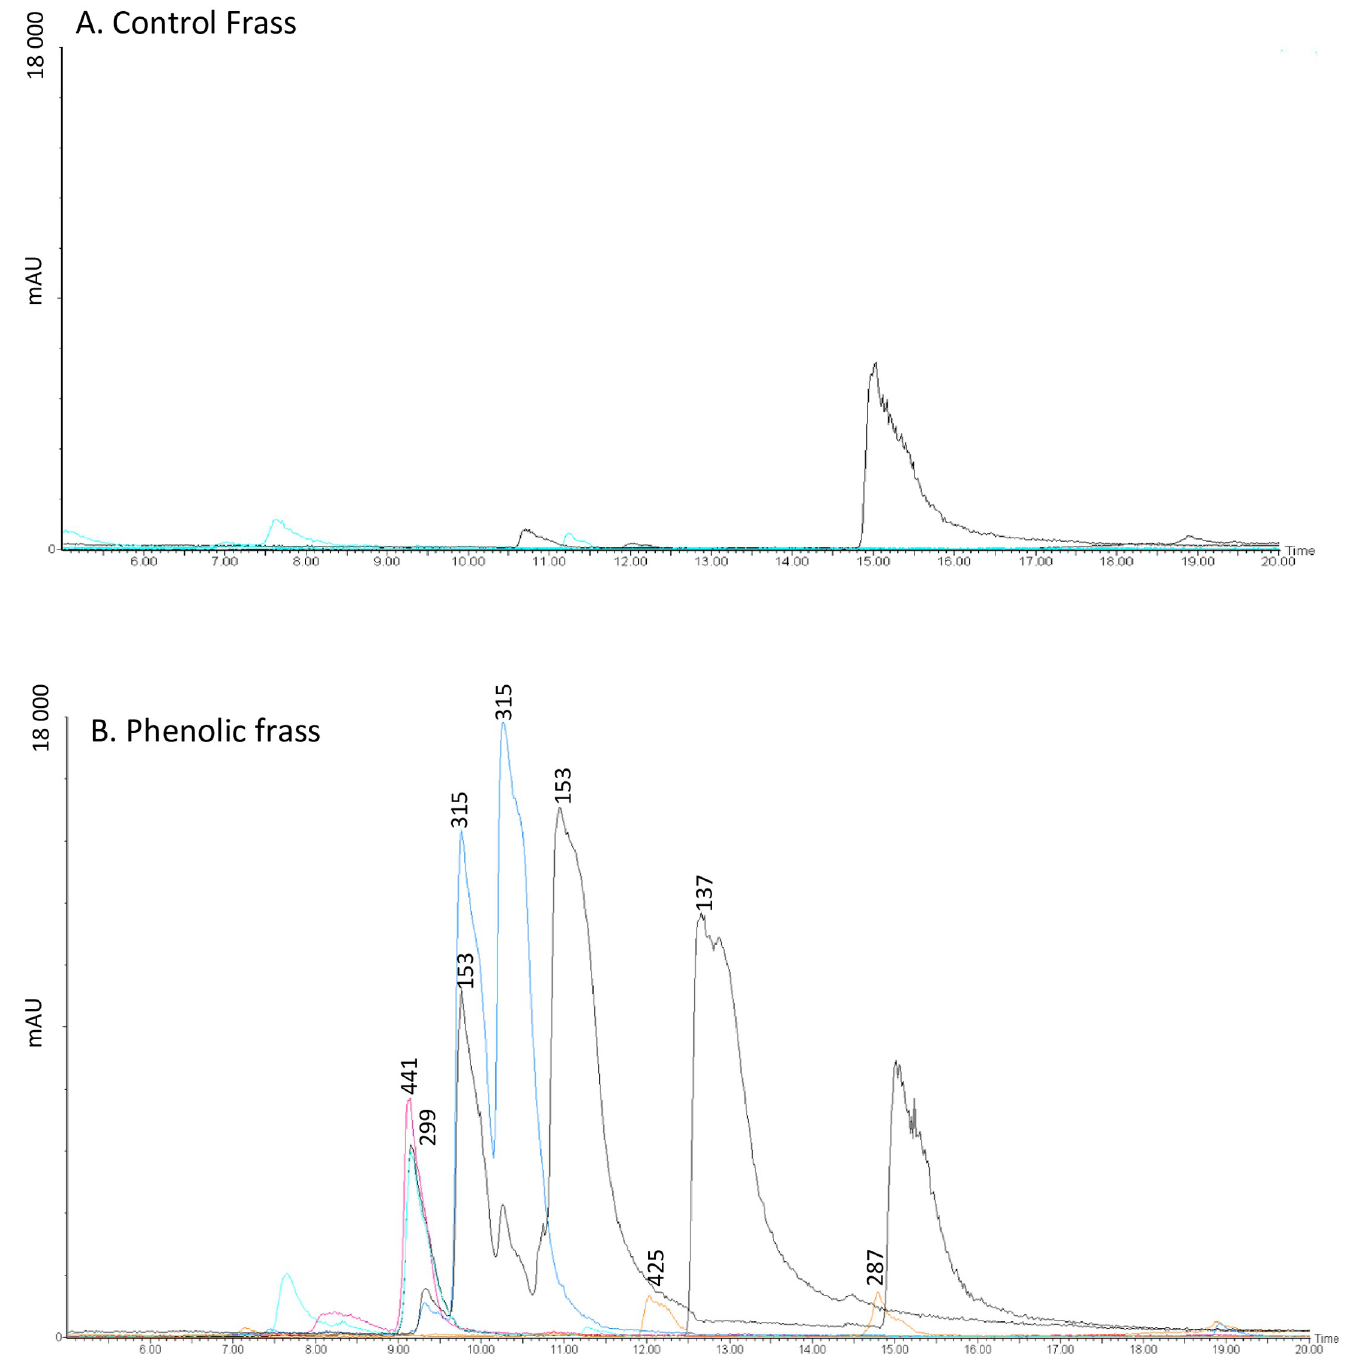
Fig 3. Frass chromatograms. HPLC-DAD chromatograms of frass from caterpillars fed A. control or B. phenolic-laced artificial diet. Numbers indicate m/z of identified peaks: 137 = piceol, 153 = pungenol, 287 = putative dimer, 299 = tentatively identified as picein, 315 = tentatively identified as pungenin, 425 = tentatively identified as a GSH-piceol conjugate, 441 = tentatively identified as a GSH-pungenol conjugate.